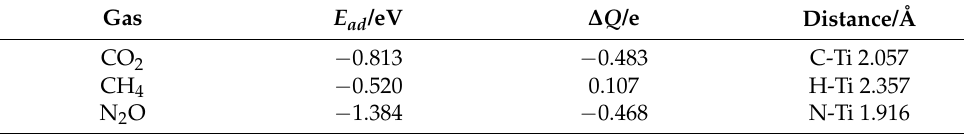
Table 2. Calculation result of CO 2 , CH 4 , and N 2 O adsorption